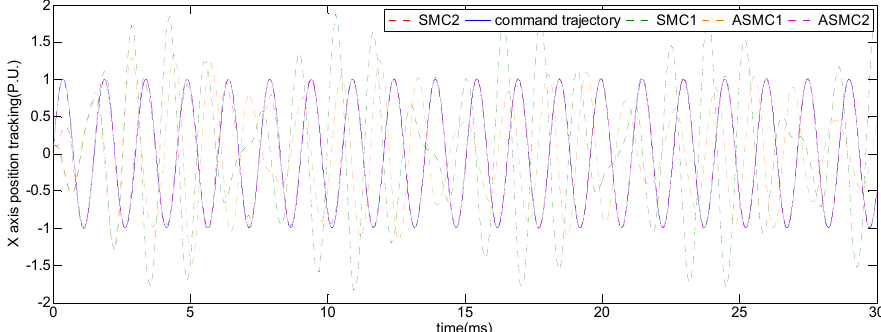
Figure 4. X axis trajectory tracking comparisons of Sliding Mode Control 1, SMC2, Adaptive Sliding Mode Control 1, and ASMC2.